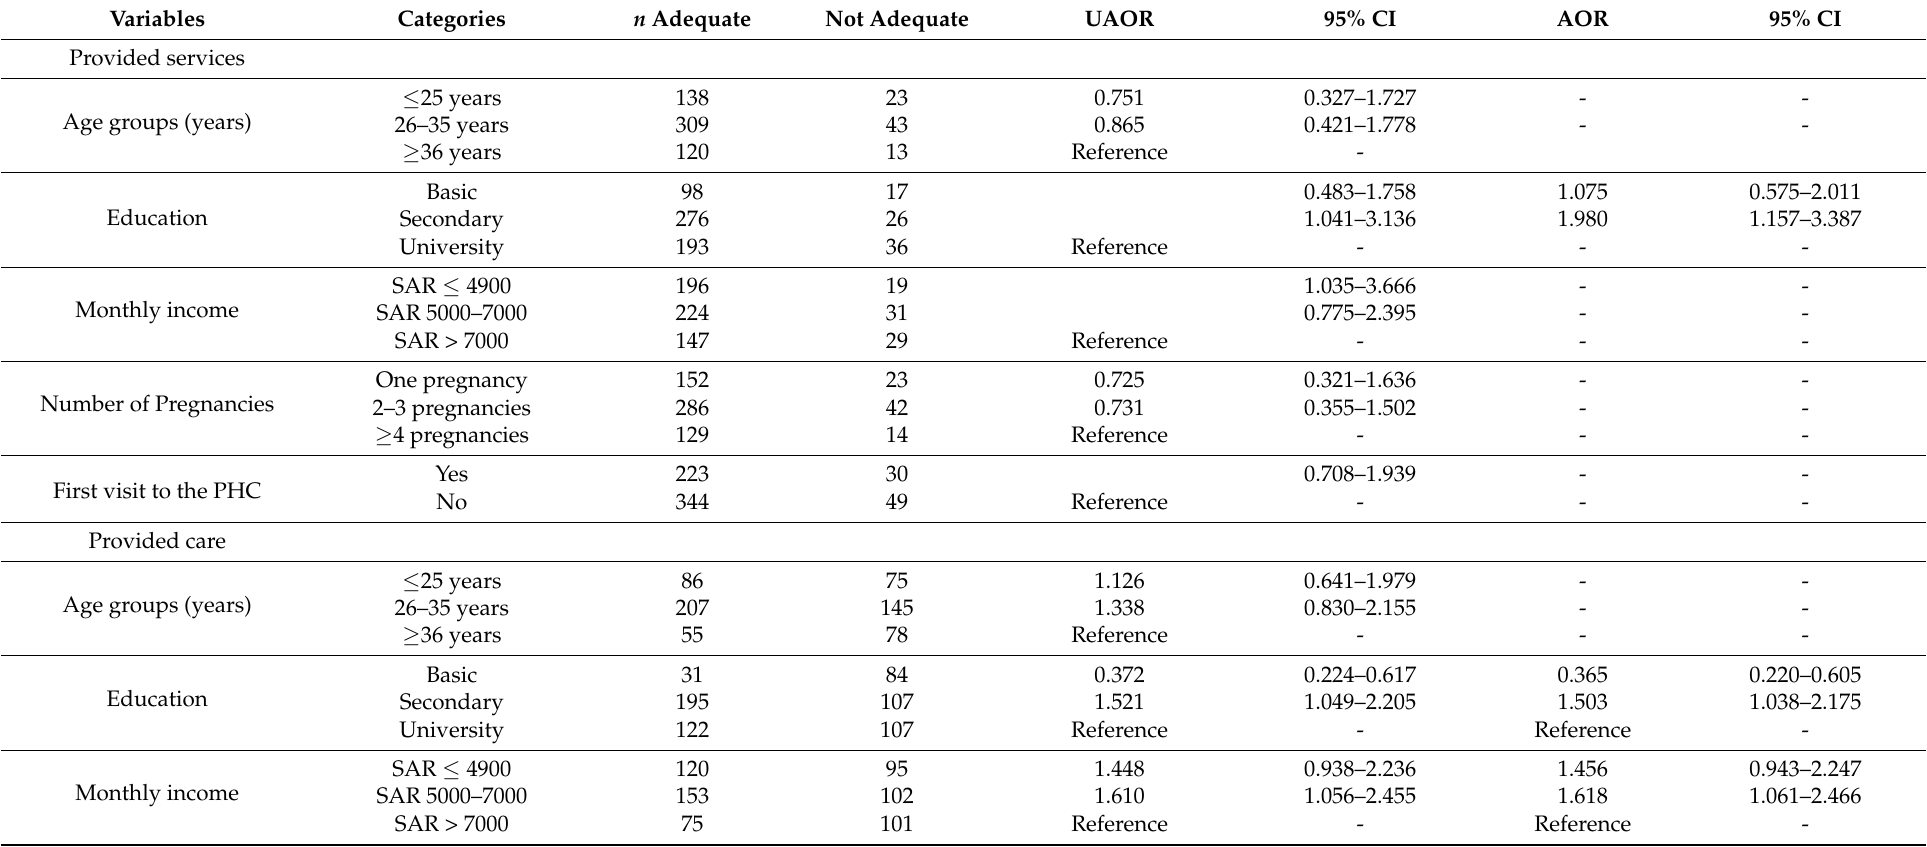
Table 3. Regression analysis between the satisfaction level with provided services, provided care, provided consultation, and participants